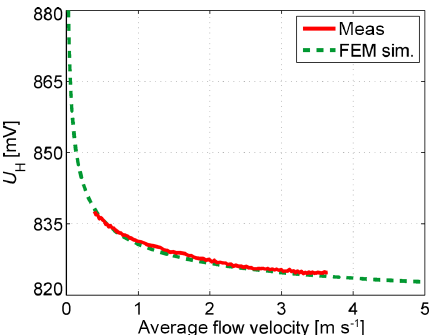
Figure 6. Voltage of the heater U H as a function of the average flow velocity in the channel. The measured results are compared with FEM simulation